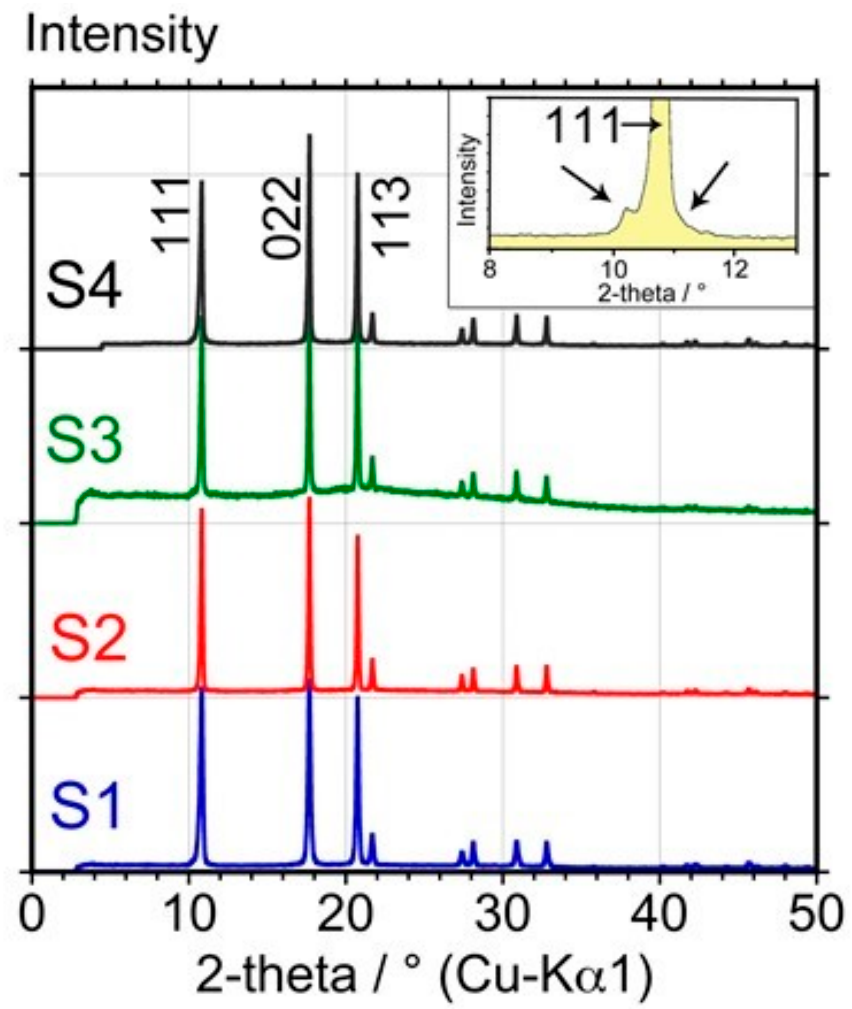
Figure 2. High-resolution X-ray powder diffraction patterns of samples S1, S2, S3, and S4, obtained at 300 K. The arrows in the inset show how stacking faults and impurities modify the profile of the 111 reflection.